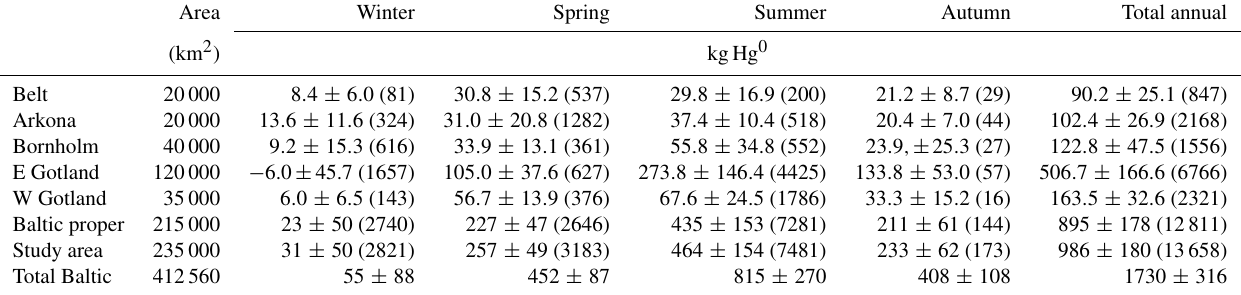
Table 5. Seasonal emissions of elemental mercury (kg) in the studied areas of the Baltic Sea. The Baltic proper comprises the Arkona Sea, Bornholm Sea, and western and eastern Gotland Sea. Extrapolation to the total Baltic Sea is based on the area ratio (see text). Hg 0 values are reported as the sum ± standard deviation, with the number of samples shown in